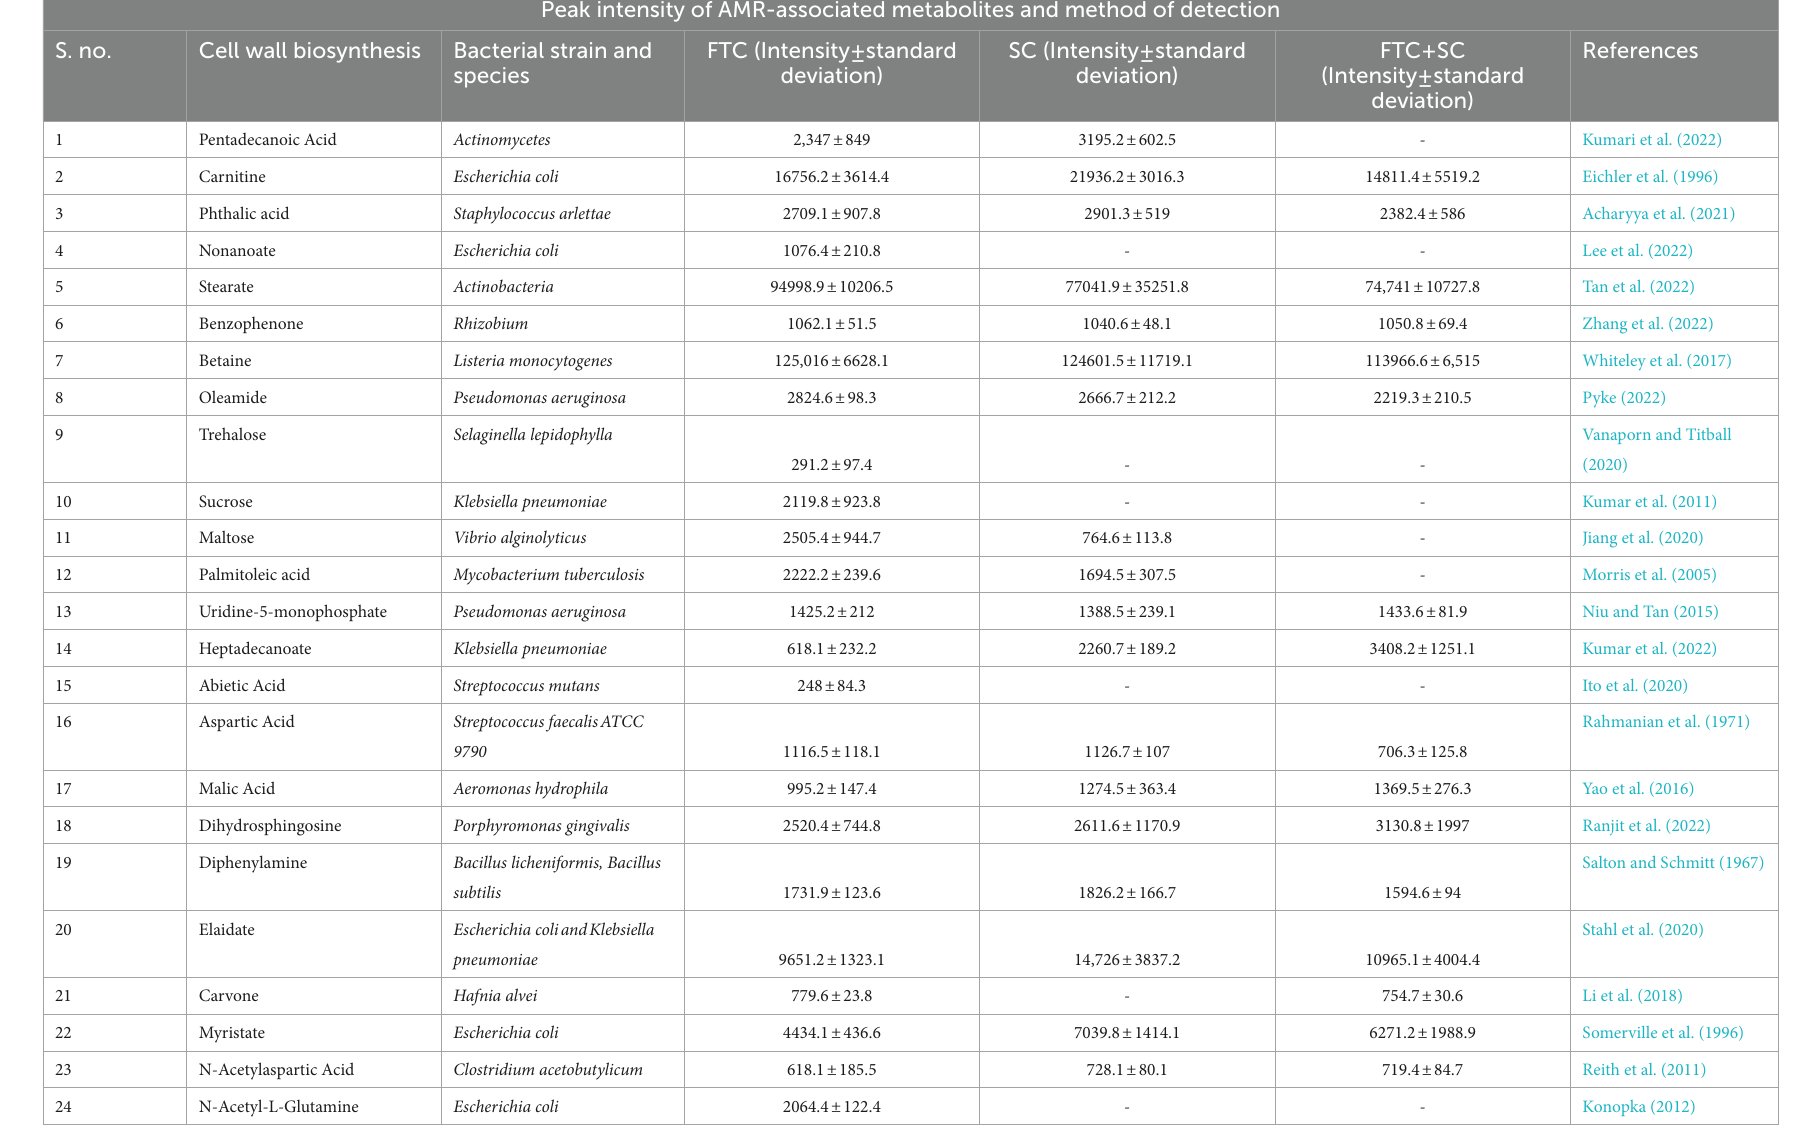
TABLE 3 Comparative overview of identified antimicrobial resistance (AMR)-associated metabolites among three different methods of metabolite extraction used in the study. Peak intensity of AMR-associated metabolites and method of detection S.